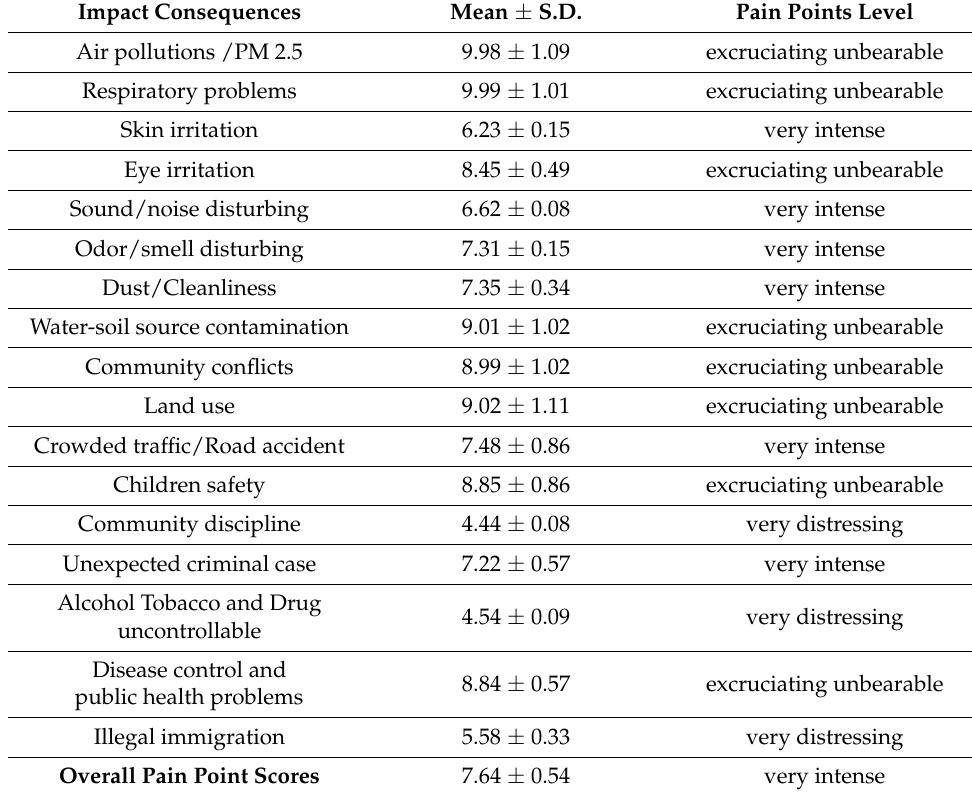
Table 3. Pain points score (N =